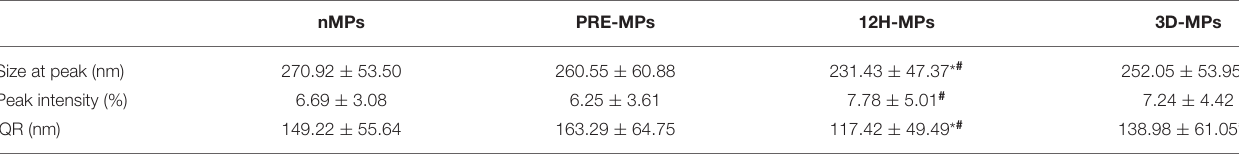
TABLE 3 | The size distribution of MPs.